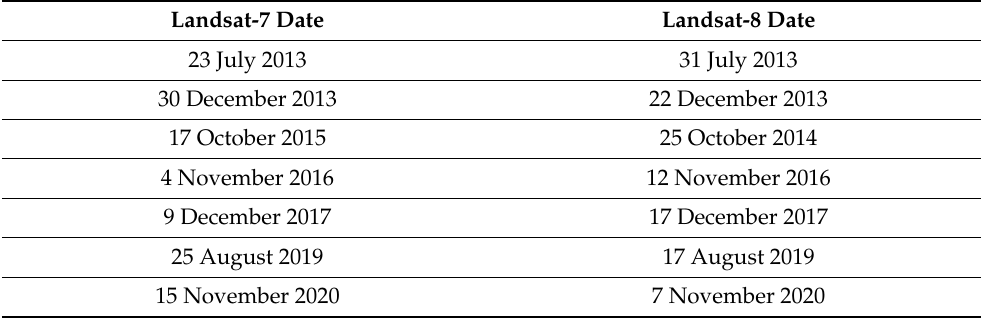
Table 4. Images acquisition dates of Landsat-7 and